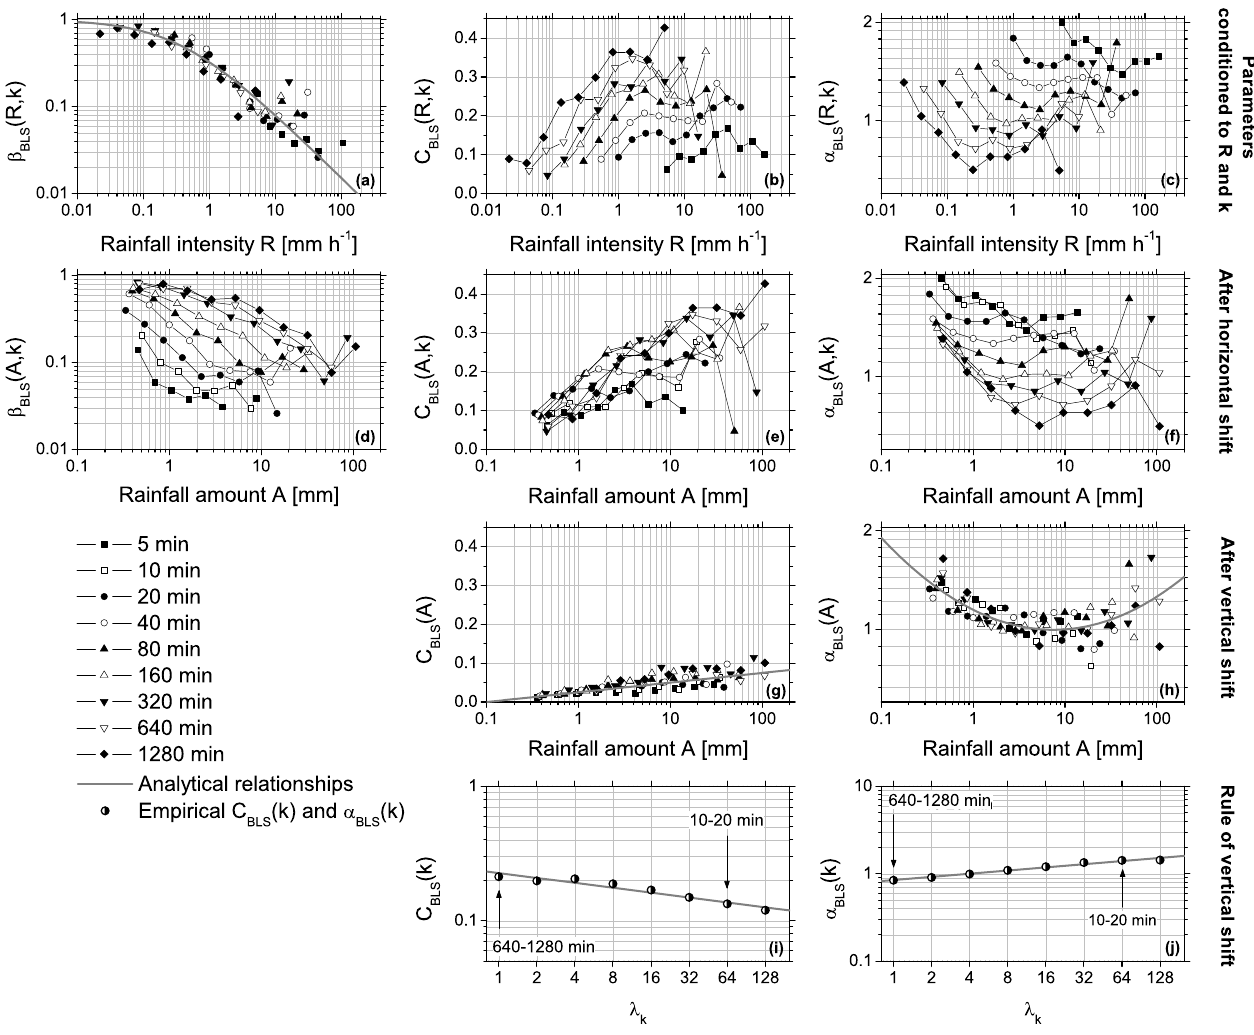
Fig. 2. Relationships among BLS parameters, time scale, and rainfall intensity R or amount A .